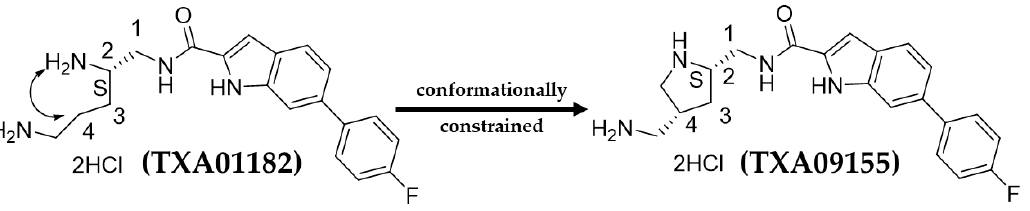
Figure 1. Structures of TXA01182 and TXA09155.